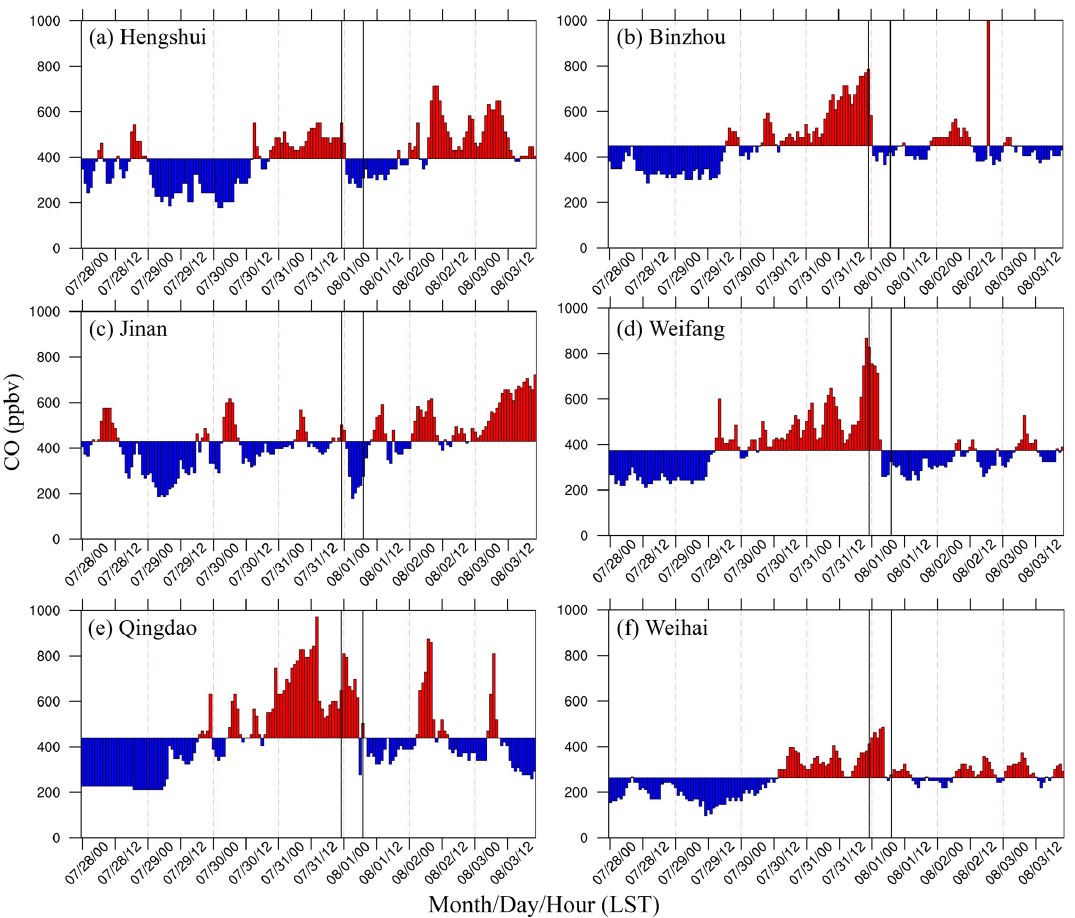
Figure 3. (a)–(f) Same as Fig. 2, but for surface carbon monoxide (CO) concentrations (unit: ppbv) from 28 July to 3 August 2021.